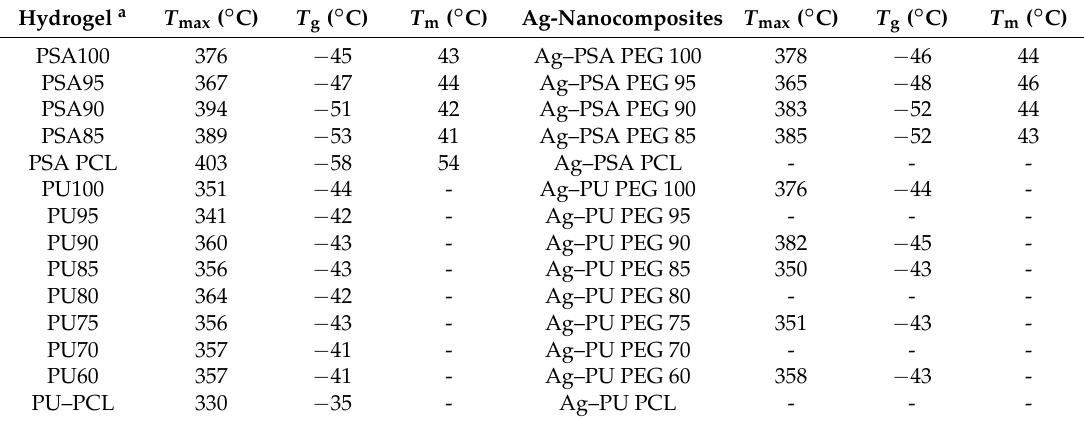
Table 1. Thermal properties of (PSA and PU) polymer hydrogels and (Ag–PSA and Ag–PU) silver hydrogel nanocomposites: maximum degradation temperature ( T max ), glass transition temperature ( T g ) and melting temperature ( T m